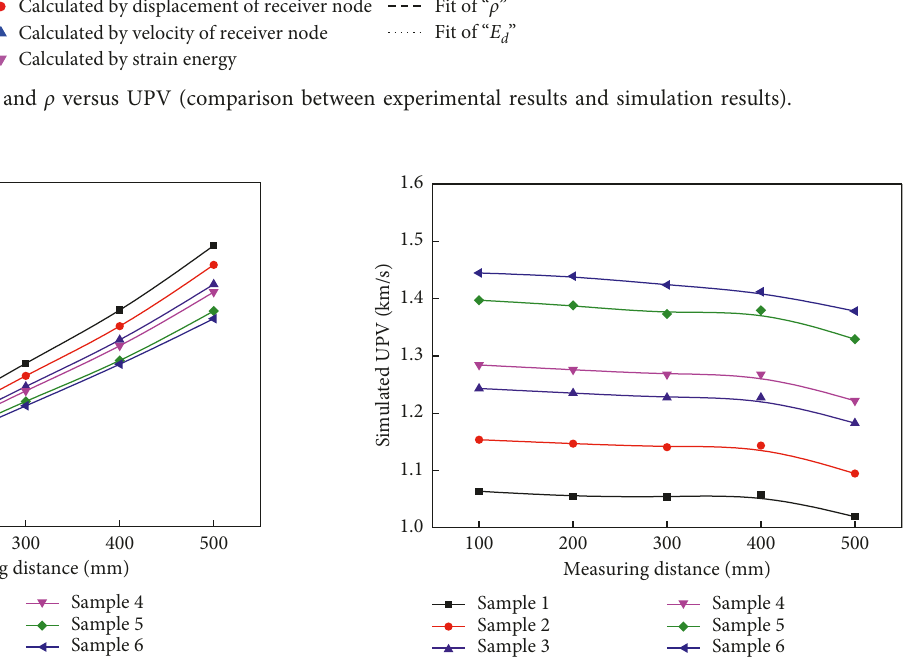
Figure 19: Arrival time versus measuring distance. Figure 20: Simulated UPV versus measuring